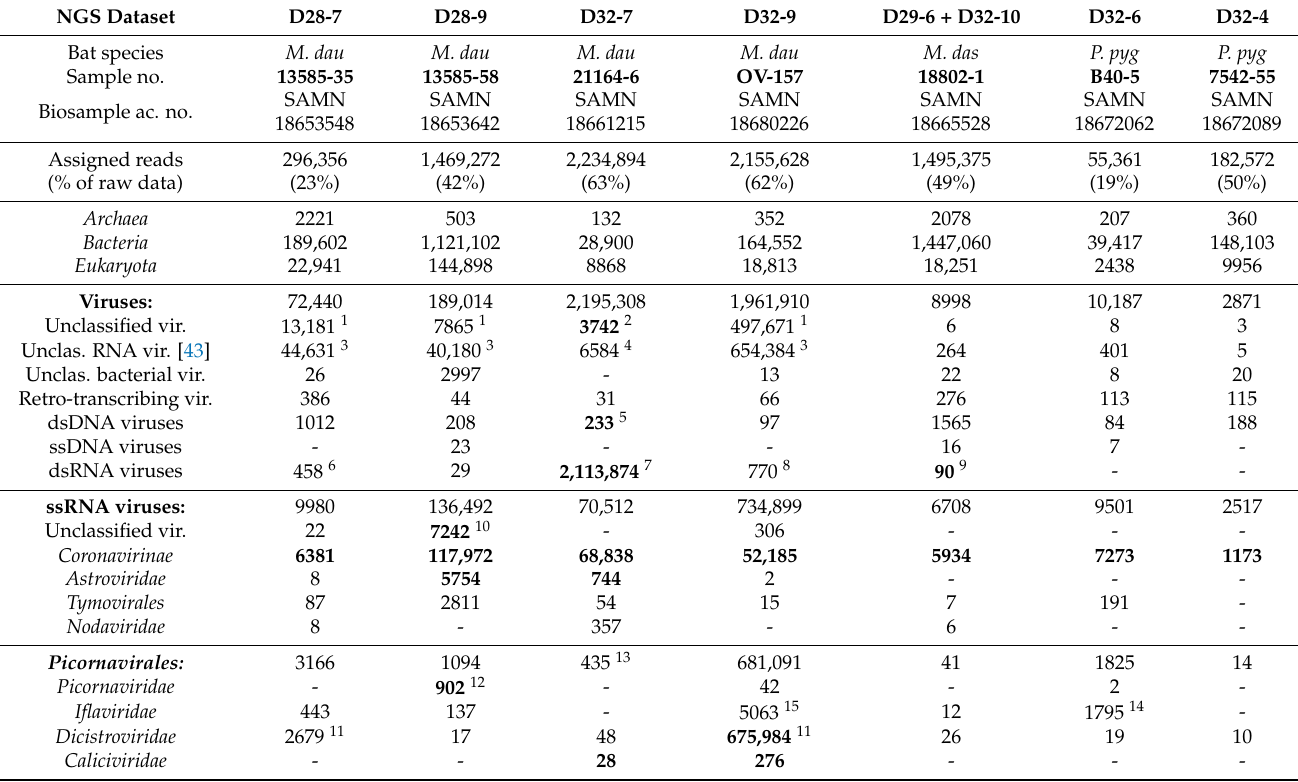
Figure 1. Comparison of full-length genomes of bat coronaviruses (BtCoVs) to one another, and to the closest matching full-length sequences from GenBank, after aligning the sequences with MUSCLE. The grouping of sequences corresponds to the clustering seen in the phylogenetic tree (Figure 2). The numbers in the upper-right part of the table are the percentage nucleotide identities between the sequences, while the lower-left part shows the actual number of nucleotide differences between the sequences. The heat map shading indicates degree of identity, with increased similarity shown by darker colours. The incomplete genome sequence BtCoV/7542-55/P.pyg/DK/2014 was not included in this analysis. The new sequences reported here are marked in bold text. Table 2. Overview of the output from Kaiju metagenomics analysis, with a focus on reads assigned to selected viruses. Read numbers highlighted in bold indicate that viral genome sequences were